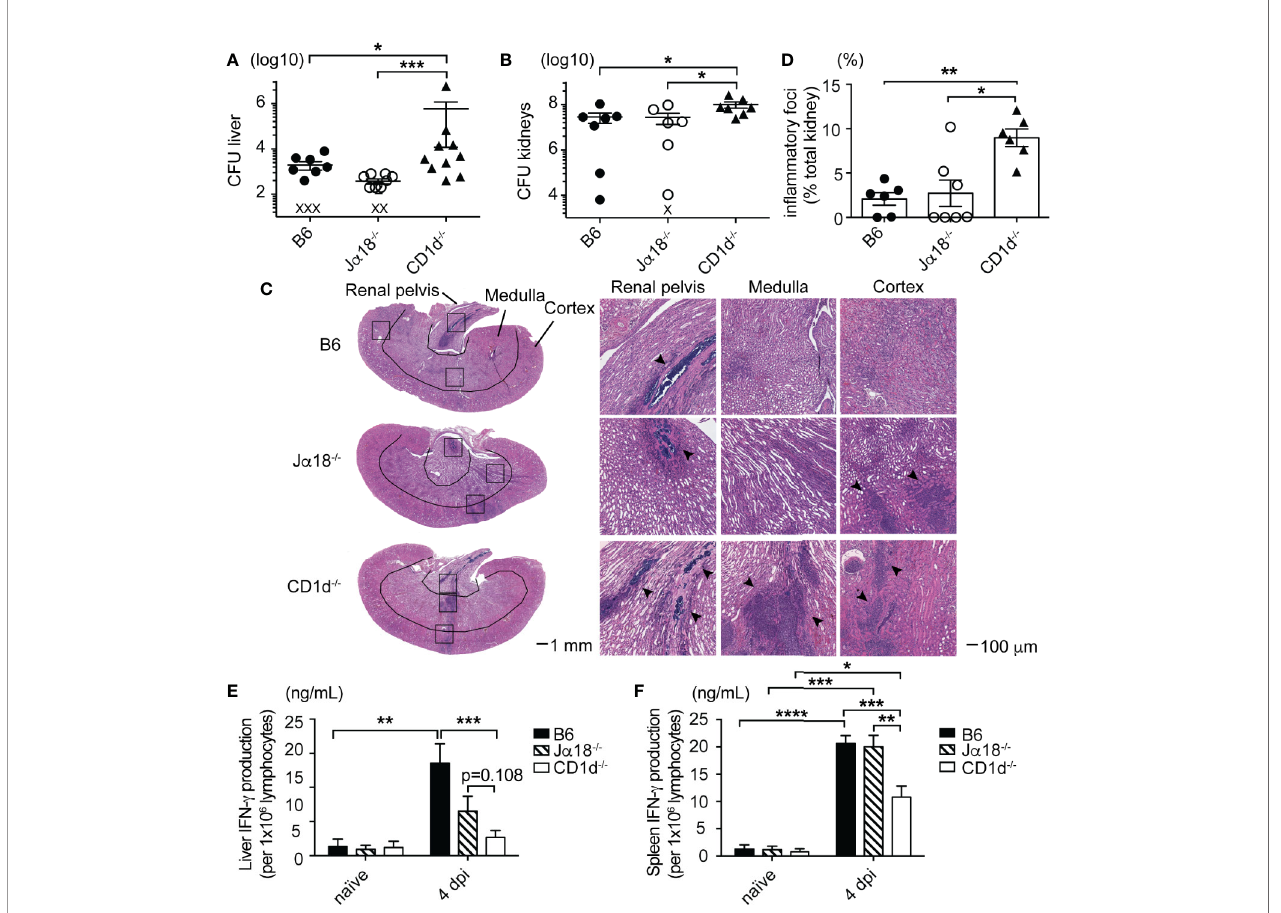
FIGURE 2 | Type II NKT cells are suf fi cient to control SA growth and mediate cytokine production in infected organs. (A, B) CFU quanti fi ed in the liver (A) and kidney (B) of indicated mice at 4 dpi: liver (N=6 – 13 mice/genotype), kidney (N=6 – 8 mice/genotype) (X=below limit of detection). (C, D) H&E staining of kidney sections at 4 dpi, in fl ammatory foci area quanti fi ed in (D) , (N=6-7 mice/genotype). (E, F) IFN- g ELISA of liver (E) and spleen (F) lymphocytes from 4 dpi mice pulsed with HKSA, unstimulated not graphed (undetectable) (N=2 – 4 naïve, N=7-10 infected mice/genotype). Statistical analysis: (A, B, D) Mann-Whitney test, (E, F) 2-way ANOVA. *p < 0.05; **p < 0.01; ***p < 0.001; ****p <